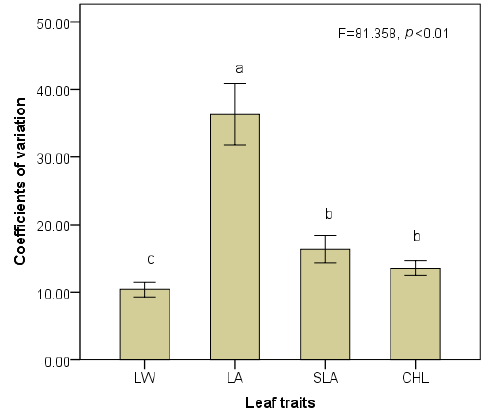
Figure 6. The coefficients of variation of four leaf traits in the study of restoration communities. The bars are the mean ± 2 SE, and the different letters indicate significant differences among the four shading treatments. LW is the leaf shape index, LA is the leaf area, SLA is the specific leaf area, and CHL is the chlorophyll concentration in the leaf that was measured as the SPAD value. Table 1. The relative percentage of variation in leaf traits intraspecies and interspecies in heterogenetic habitats that were produced by shading. The same species (n = 20) that emerged in the four treatments (trait mean of each species in each treatment, n = 4) were used for